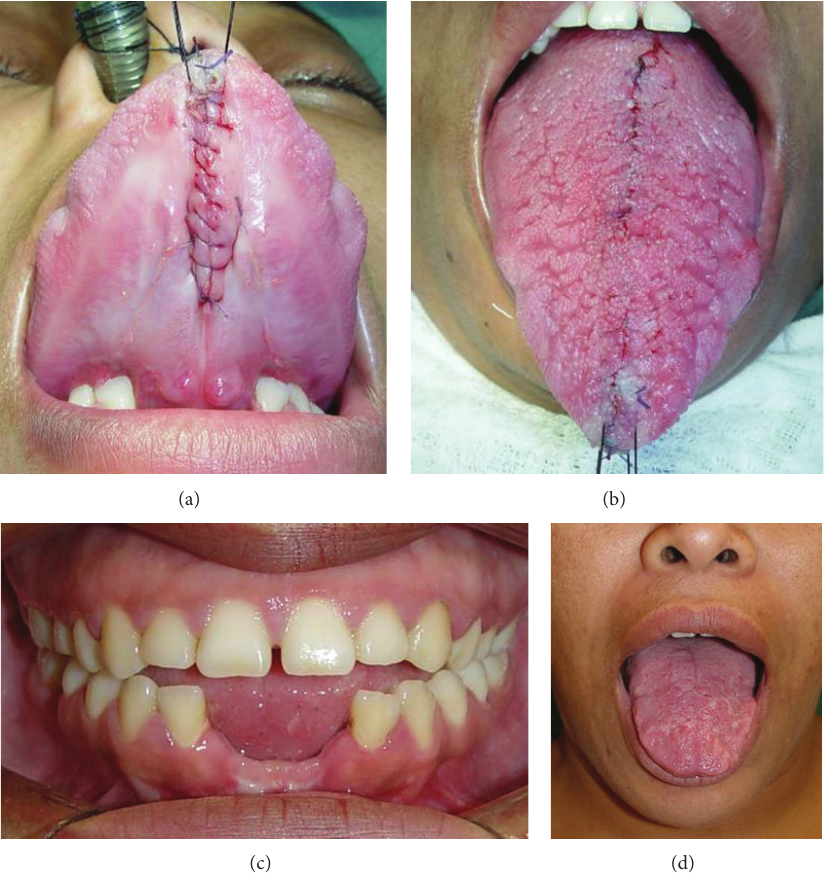
Figure 4: The suture was made by planes with polyglactin 910 suture 3-0, good tissue repair, perfect symmetry, and no tongue